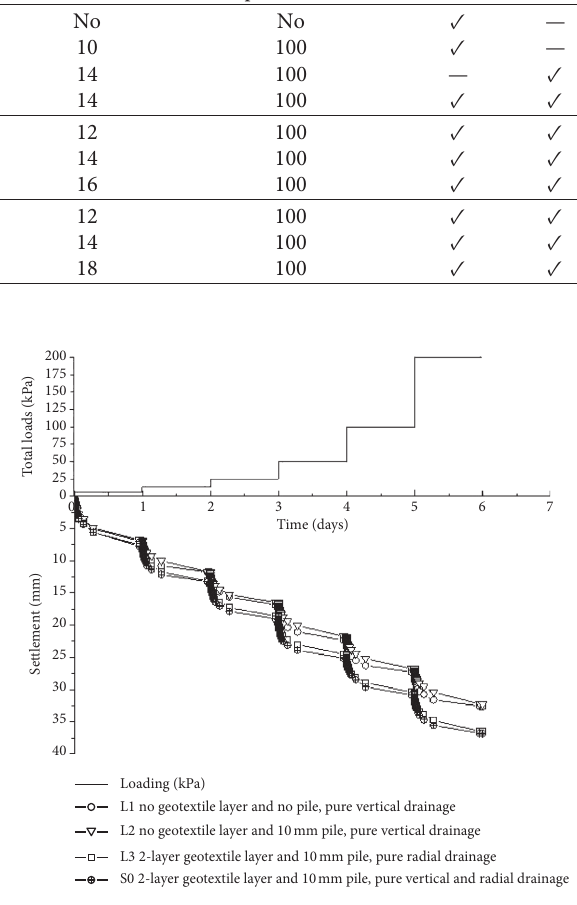
Figure 6: Relationships between consolidation settlement and time